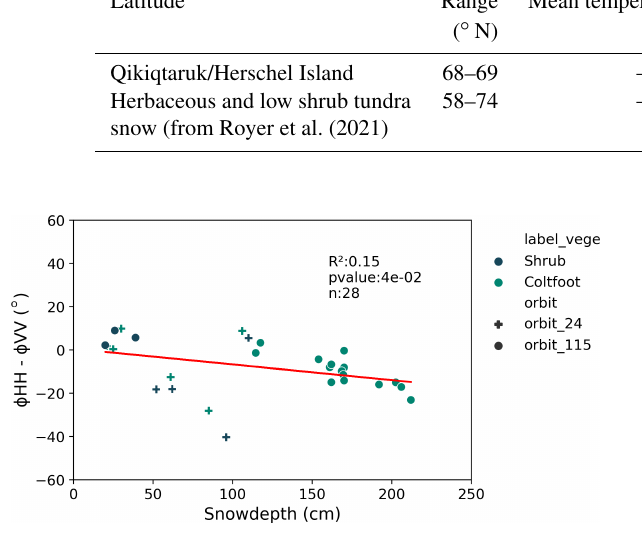
Figure B1. Linear regression between CPD and snow depth on de- scending orbit (orbits 24 and 115) without TWI threshold.